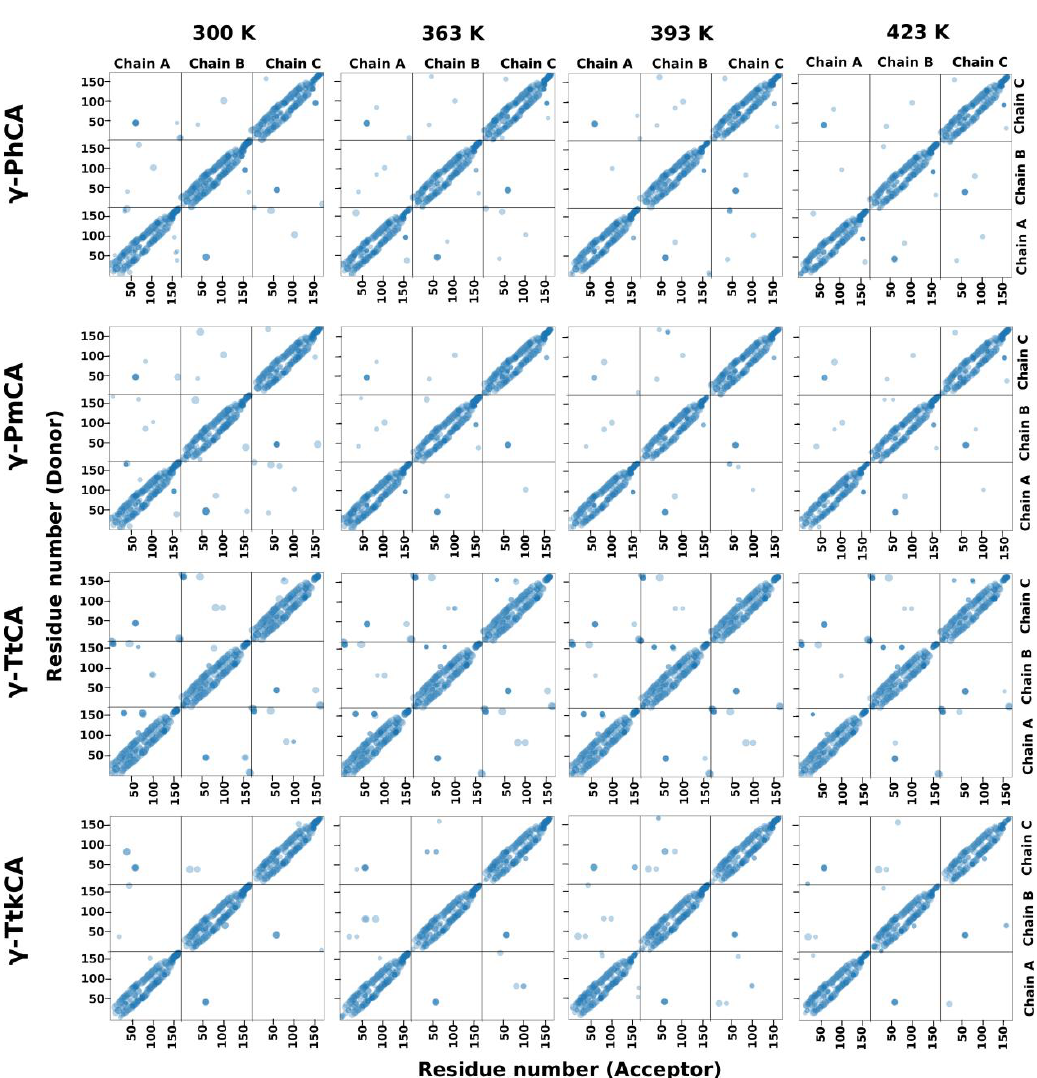
Figure 7. Hydrogen bond plots for γ - PhCA, γ - PmCA, γ -TtCA, and γ -TtkCA at 300 K, 363 K, 393 K, and 423 K. Hydrogen bonds present for ≥ 25% of the simulation are illustrated as translucent blue spheres and the color intensity increase with an increase in bonds formed by those particular residues. Sphere size is directly proportional to the fraction of the simulation a hydrogen bond was present, i.e., the larger the spheres show the longer the bond was present and vice-versa.